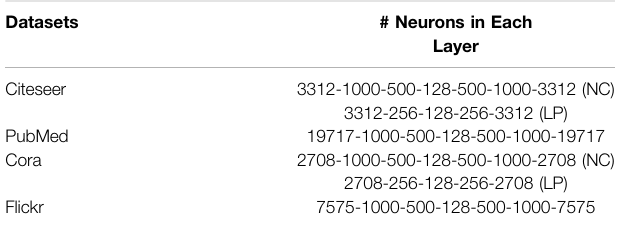
TABLE 6 | Detailed architecture information for datasets ( DANRL-CA-CSM/ Infomap ). Datasets